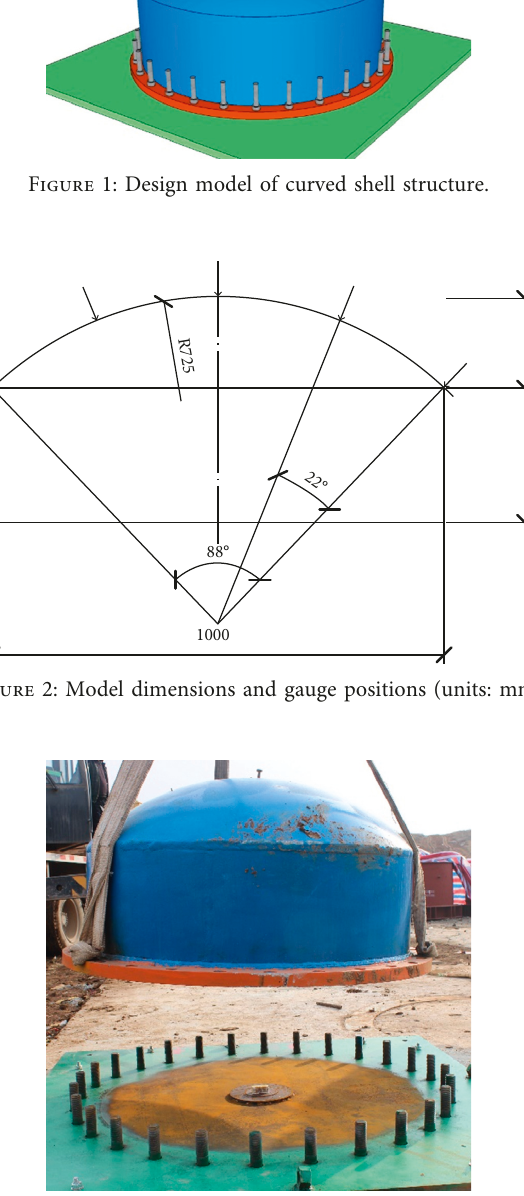
Figure 3: Test model